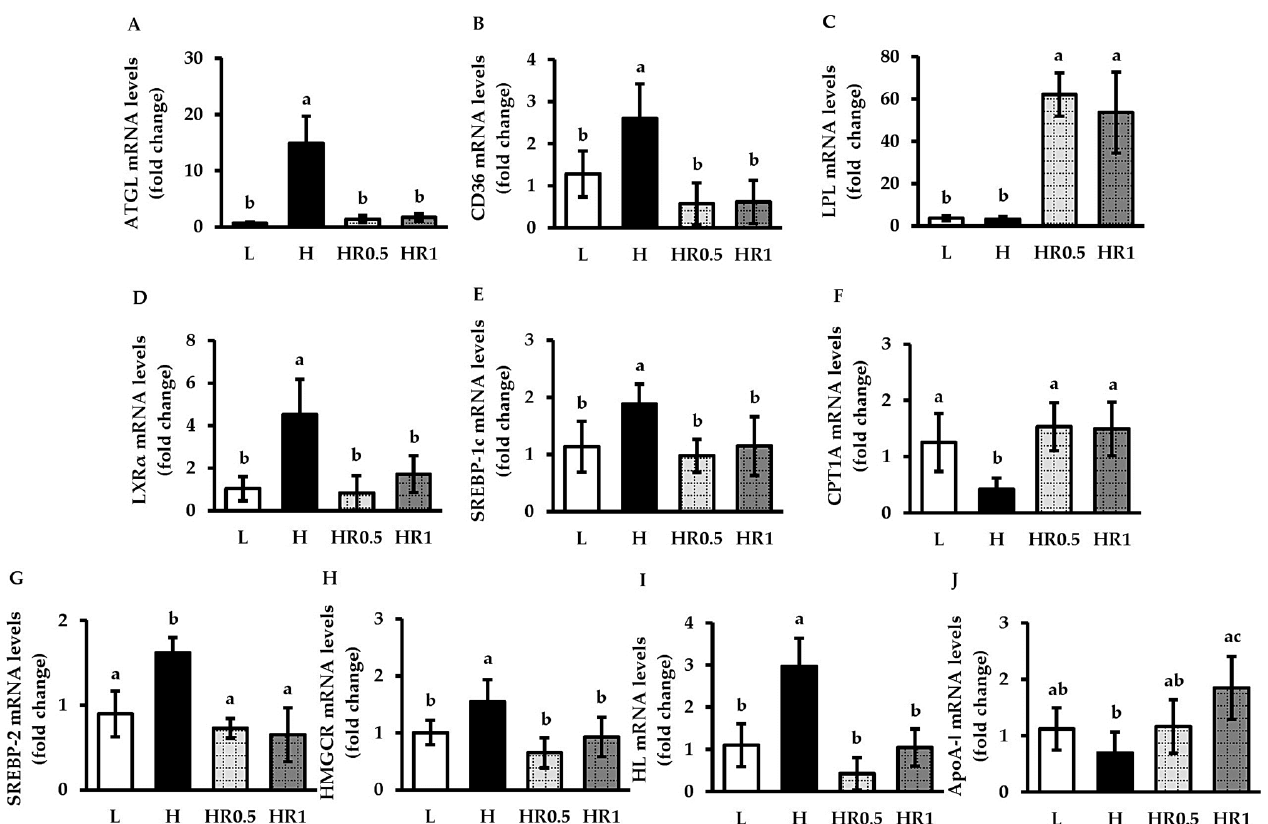
Figure 3. Effects of RRBE on the expression of lipid metabolism-associated genes in mice with HFD- induced NAFLD and dyslipidemia: ( A ) adipose tissue ATGL mRNA levels; ( B ) liver CD36 mRNA levels; ( C ) adipose tissue LPL mRNA levels; ( D ) liver LXR α mRNA levels; ( E ) liver SREBP-1c mRNA levels; ( F ) liver CPT1A mRNA levels; ( G ) liver SREBP-2 mRNA levels; ( H ) liver HMGCR mRNA levels; ( I ) liver HL mRNA levels; ( J ) liver ApoA-| mRNA levels. Values are means ± SD; 6 mice/group. Statistically significant difference at p < 0.05 was analyzed using one-way ANOVA with Tukey’s test and is indicated by different letters above error bars. The L, LFD, and distilled water co-treated group; H, HFD, and distilled water co-treated group; HR0.5, HFD, and middle-dose (0.5 g/kg) RRBE co-treated group; HR1, HFD, and high-dose (1 g/kg) RRBE co-treated group.